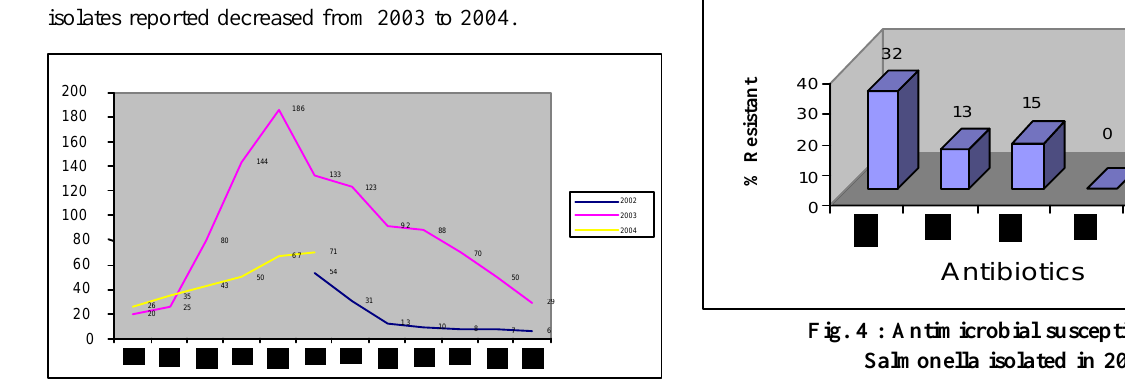
Fig. 1 : Monthly distribution of isolates analysed.